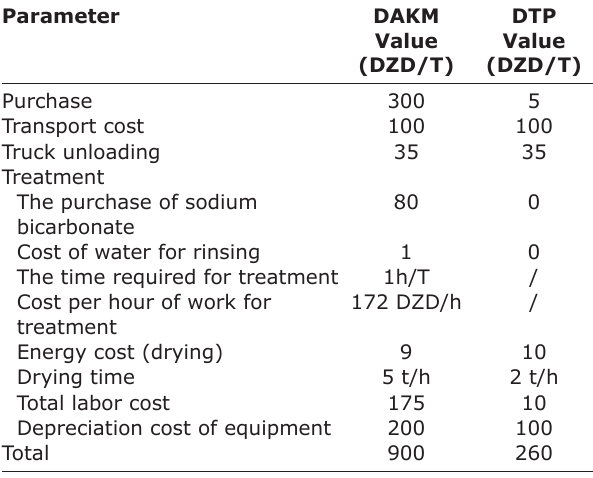
Table- 3: Data used to estimate the cost of DAKMs and